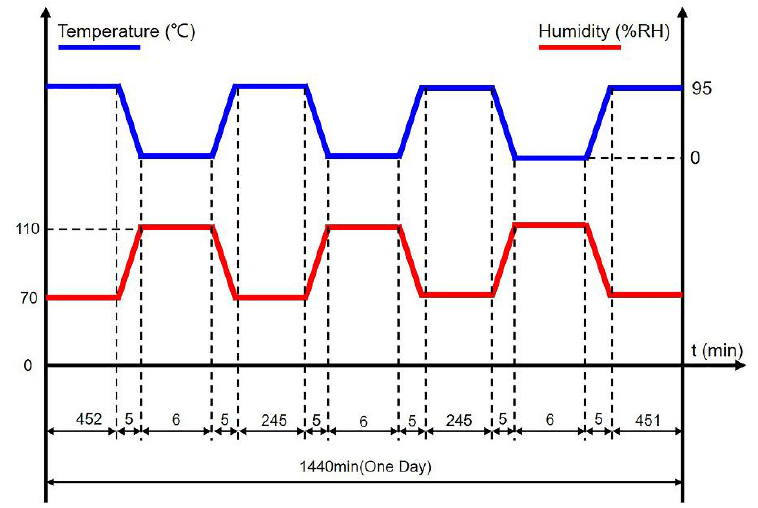
Figure 4. Accelerated hygrothermal aging spectrum for the 3D braided composites.